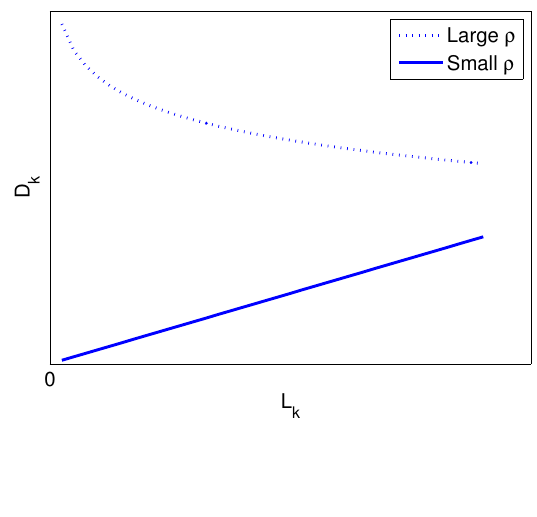
Figure 9. Relative entropy D large ρ region, and the solid line is the case in the small ρ